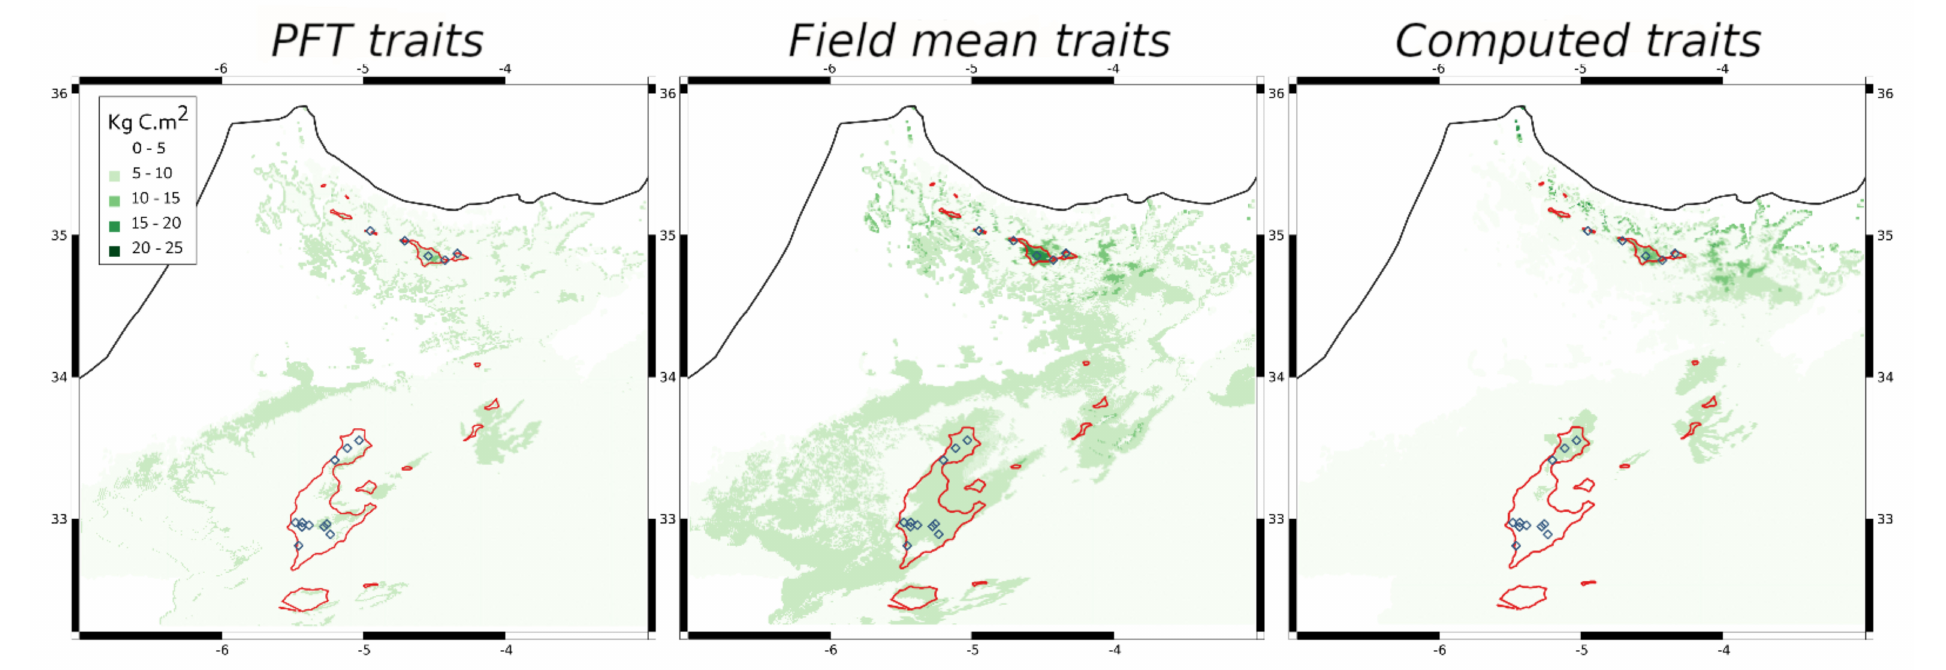
Figure 8. Predicted biomass in 2016. Comparisons of simulation outputs using PFT traits , field mean traits or computed traits with sampling locations (blue squares), and contours of the extant distribution (red lines). The threshold of 11.7 kg C/sq. m corresponding to the lowest recorded field value (site #9) was only reached in the Rif with the field and the computed trait